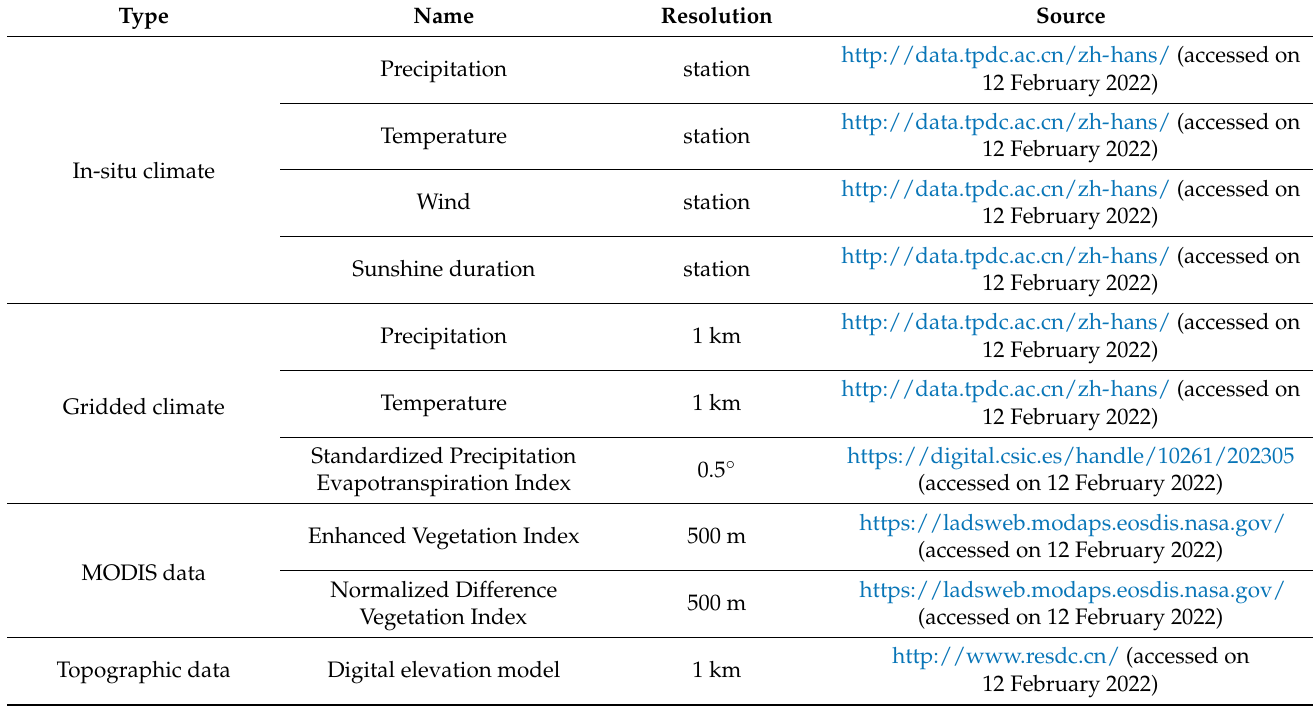
Table 1. Information about the data used in this study.